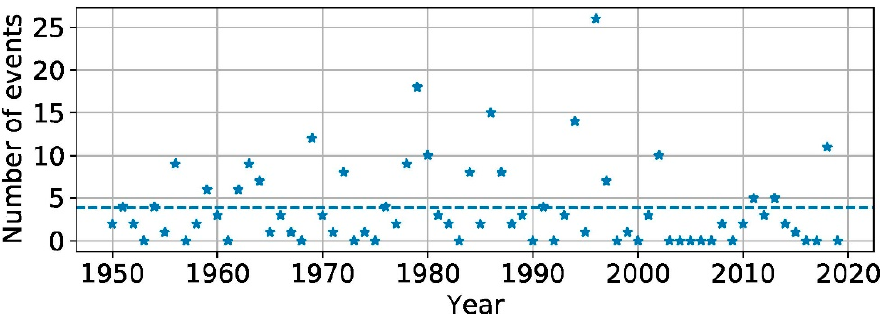
Figure 5. Distribution of the number of ELWs per year (stars; mean value as dashed line) at the tide gauge Cuxhaven for the time period from 1950 to 2019.